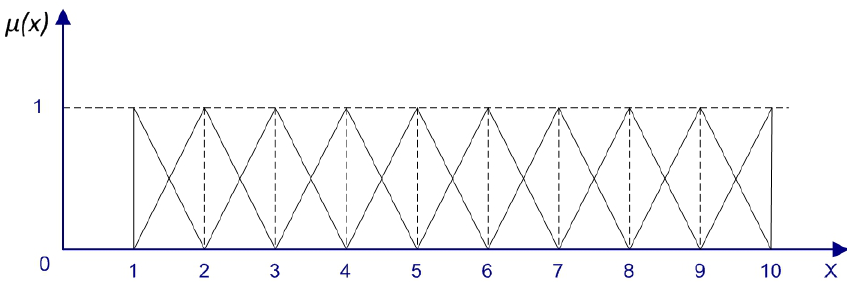
Fig. 6. Fuzzy environment (Wang et al. 2009) Khan